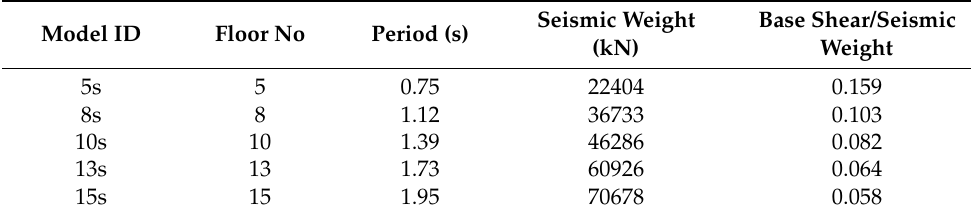
Table 3. Structural properties of frame building models.